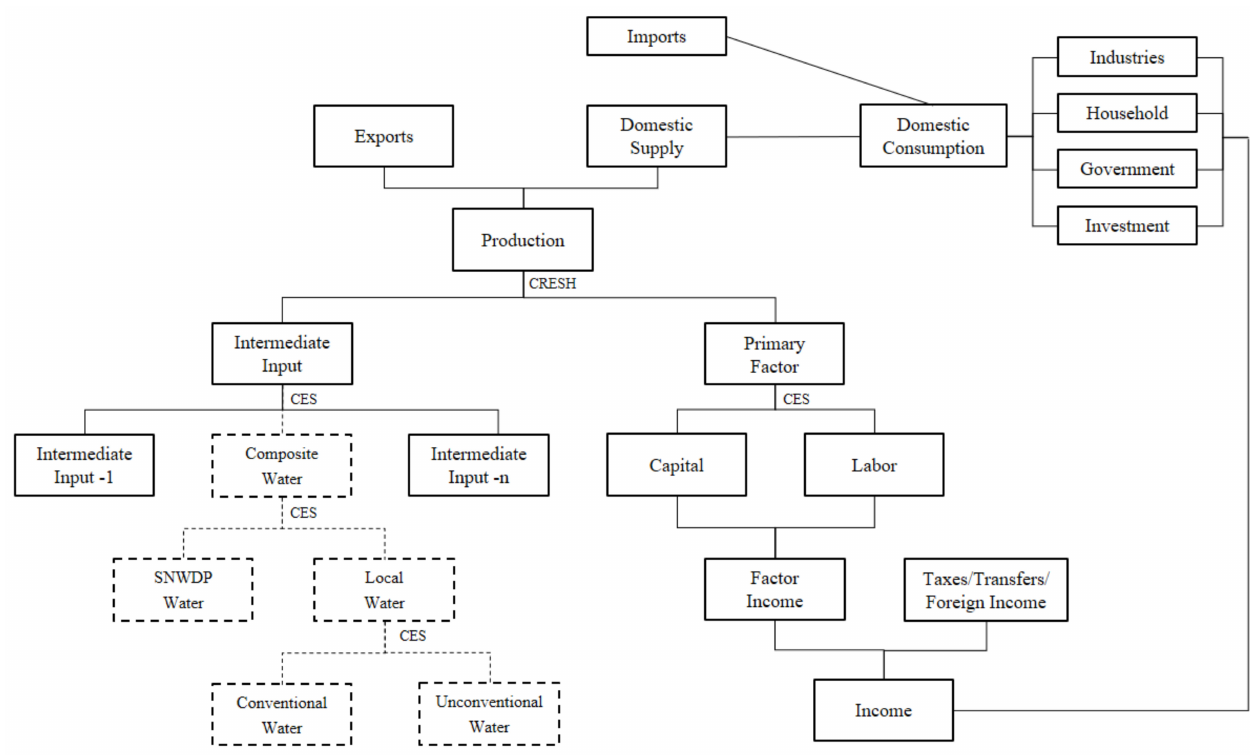
Figure 2. Schematic of model